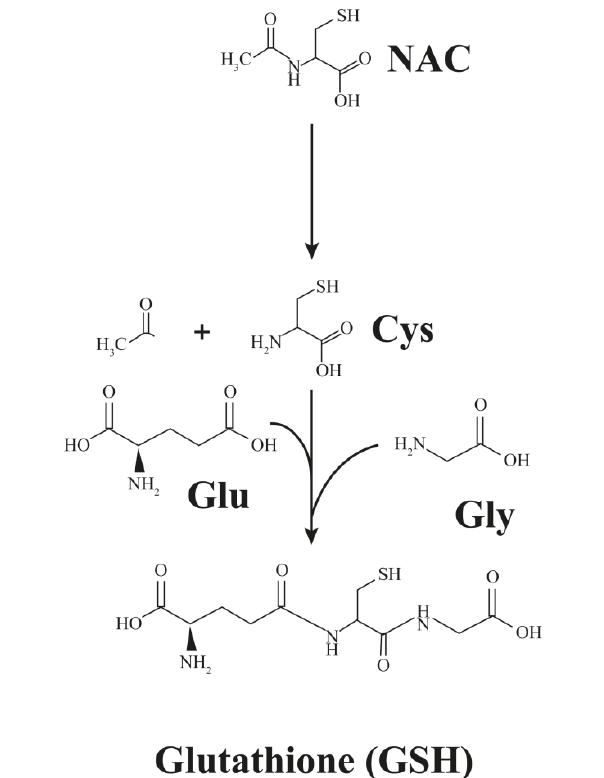
Figure 2. N-acetylcysteine (NAC) as a cysteine donor for glutathione synthesis. Most of the anti-oxidant activity of NAC is thought to be related to its pro-glutathione (GSH) properties. NAC serves as a donor of cysteine residues that are essential to GSH synthesis. Adapted Rushworth and Megson (23).